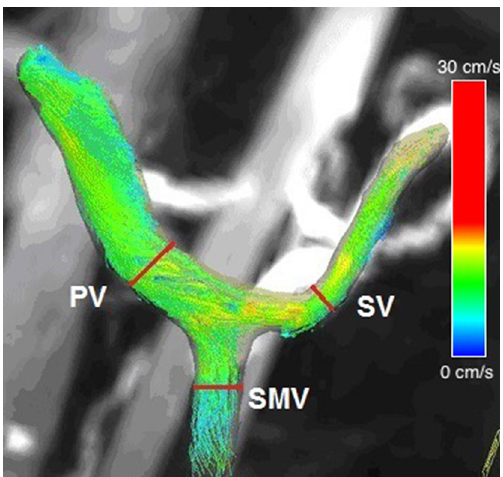
Figure 2. Segmentation of venous vessels with planes of analysis